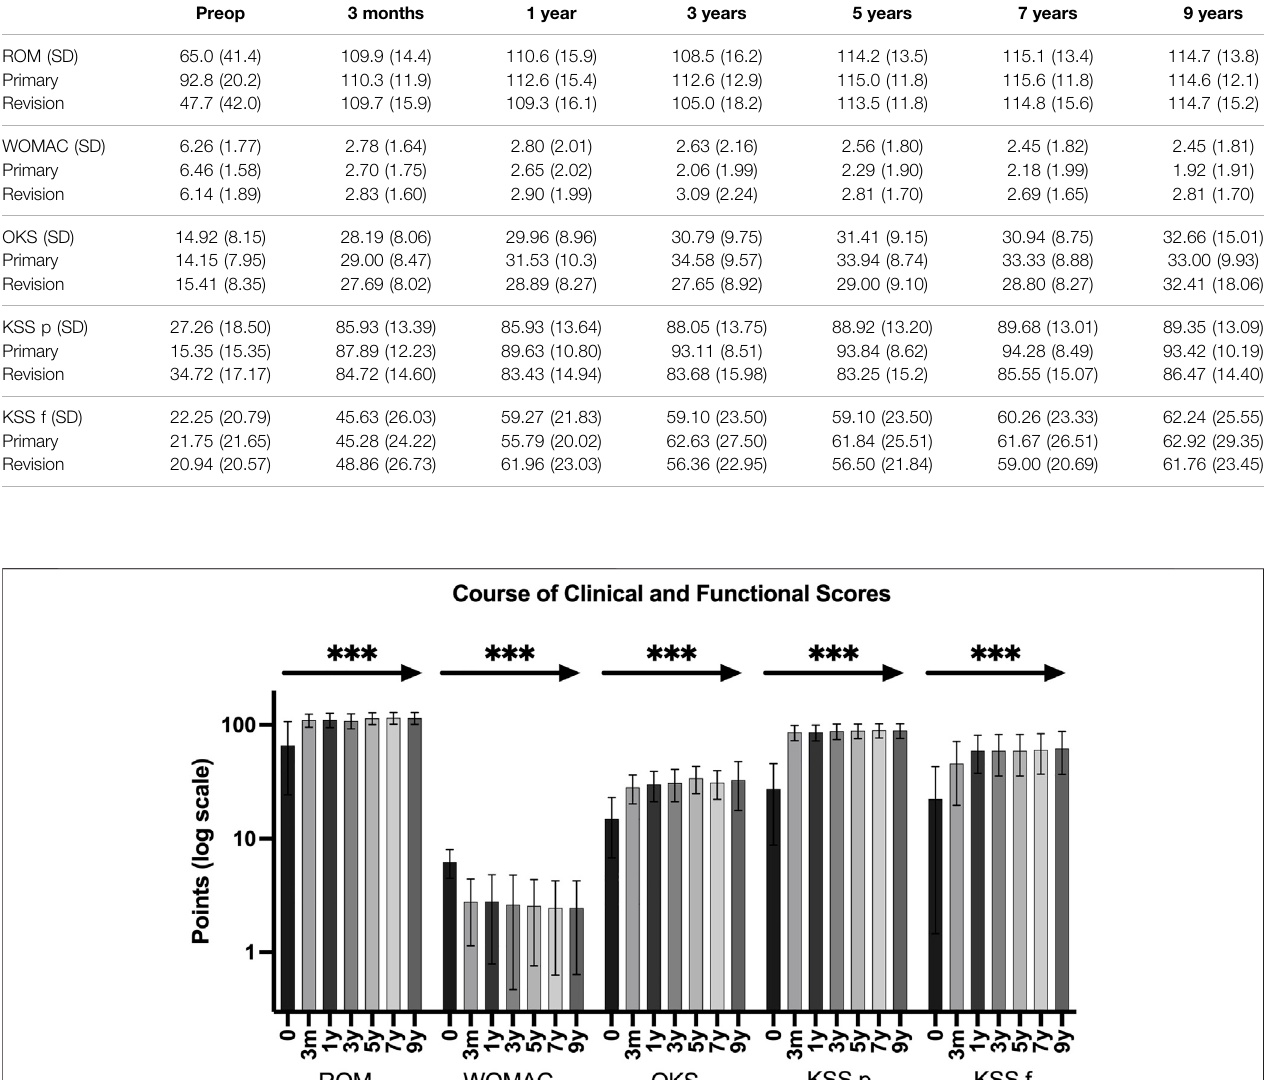
Table 2 ; Figure 1 display an overview of clinical and functional